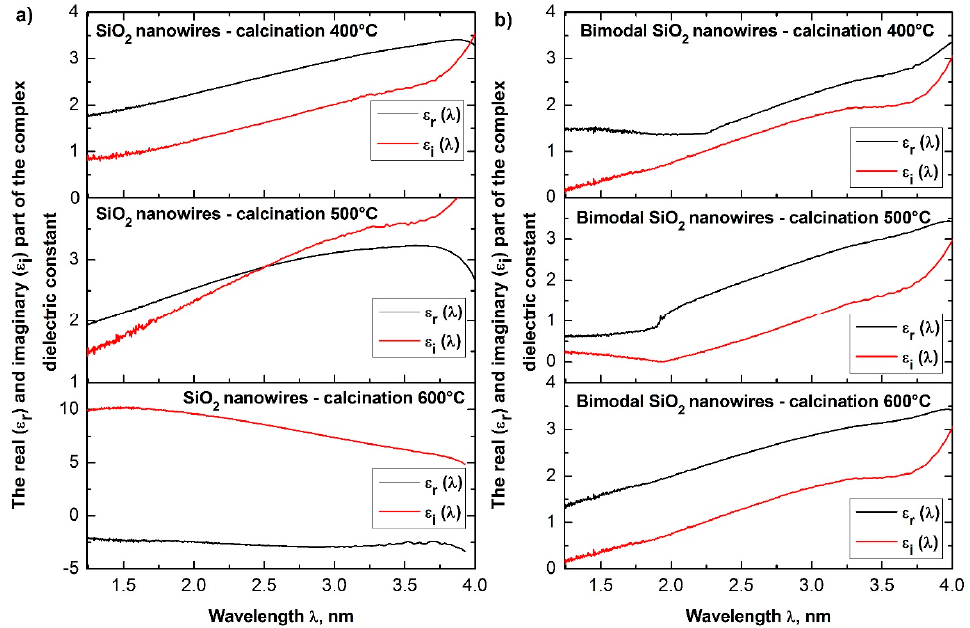
Table 1. Determined values of the complex refractive index, dielectric permittivity and energy gap width values obtained for the produced nanowires. Figure 14. Dependences of the real ε r ( λ ) ( a ) and imaginary ε i ( λ ) parts ( b ) of the dielectric constant for the produced SiO 2 ceramic nanowires and bimodal SiO 2 /SiO 2 nanowires.